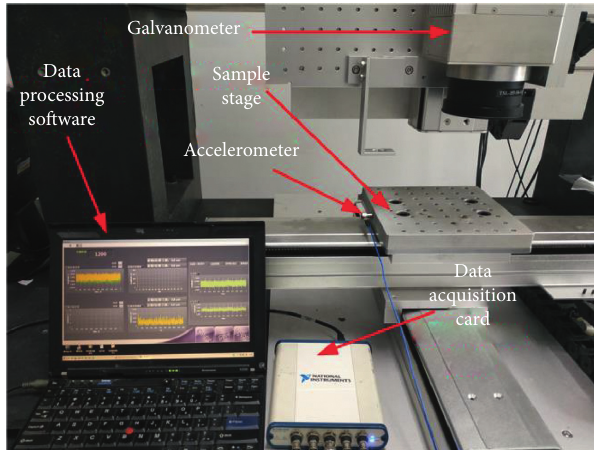
Figure 6: Experimental